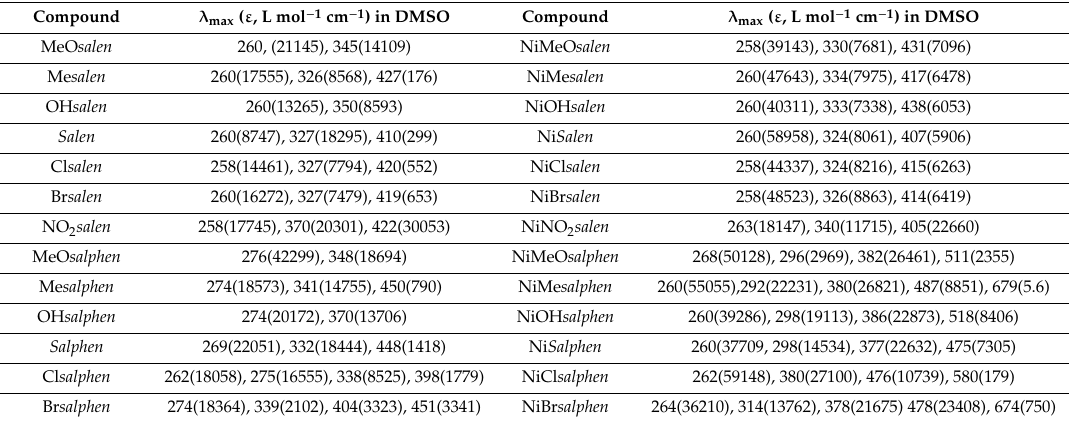
Table 2. Electronic spectral data of the Schi ff bases and their